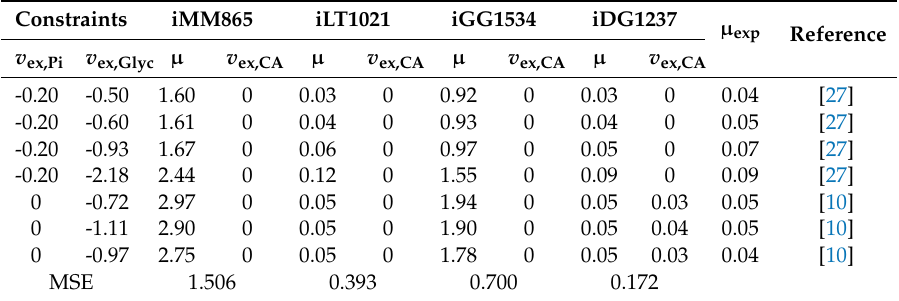
Table 2. Comparison of experimental and in silico growth rates for S. clavuligerus models. Constraints iMM865 iLT1021 iGG1534 iDG1237 µ